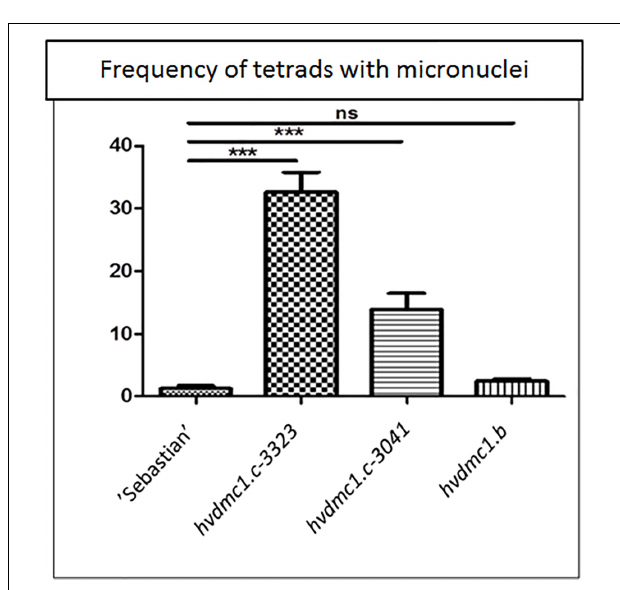
FIGURE 9 | Comparison of the frequency of tetrads with micronuclei in ‘Sebastian’ (wt) and three dmc1 mutants. Stars indicate statistically significant differences (ANOVA; p < 0,05) between ‘Sebastian’ and the three dmc1 mutants, ns – differences between compared genotypes were not statistically